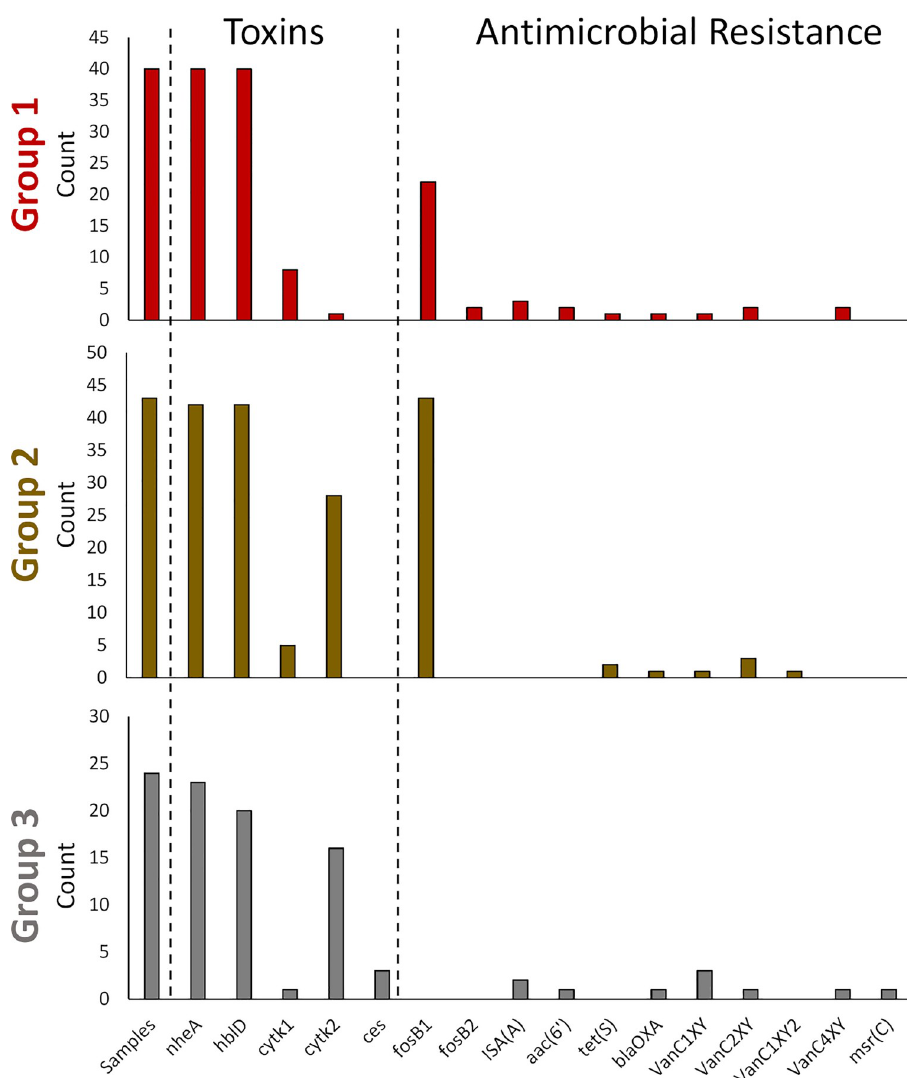
Fig 3. Toxin and AMR genes identified in B . cereus samples. The total number (count) of samples, toxin genes (real- time PCR) and AMR results are presented for each group. Details on each sample are in S10 Table. The group assignments are indicated by the same colours used in Figs 1 and